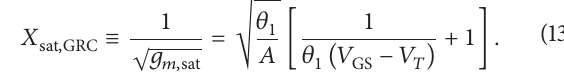
as expected by the second GS values from GS